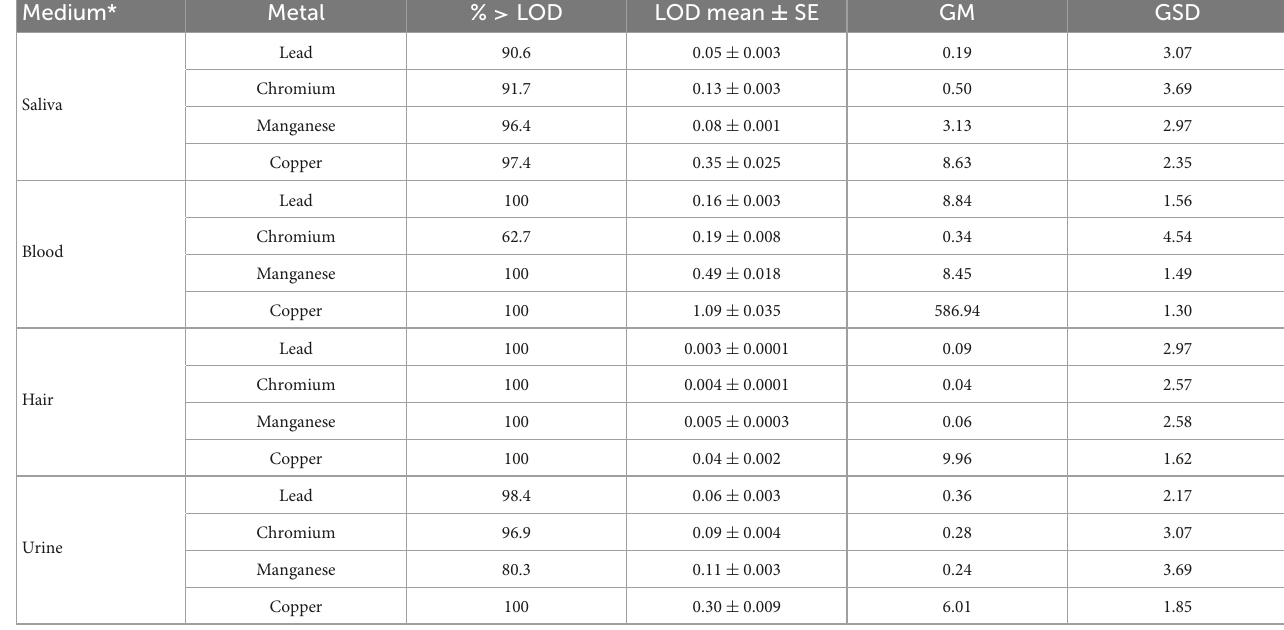
TABLE 1 Metal concentrations (Mn, Pb, Cr, and Cu) measured in blood, urine, hair, and saliva collected from 193 adolescents participants PHIME-MRI included in the current study.